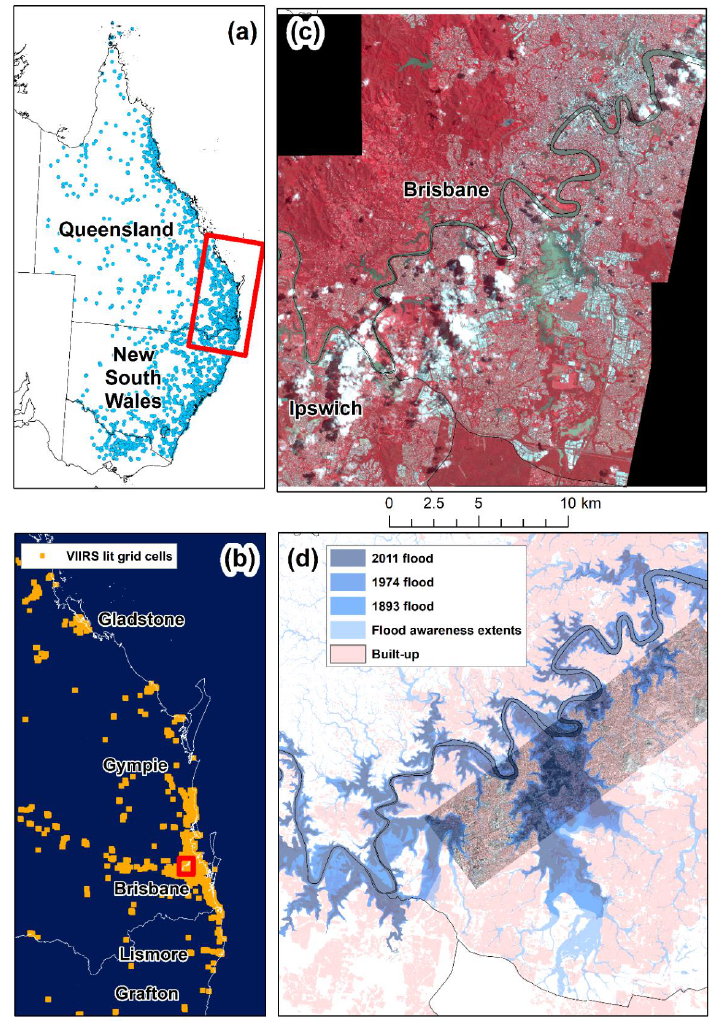
Figure 1. Study area: ( a ) Bureau of Meteorology river gauge stations in Queensland and New South Wales; ( b ) VIIRS lit grid cells which were analyzed; ( c ) PlanetScope imagery from peak flood day in Brisbane, 28/2/2022; ( d ) past extent floods in Brisbane and built-up areas (from the global urban footprint; Esch et al., 2017) with the Capella SAR image acquired on 28 February 2022 in the background.